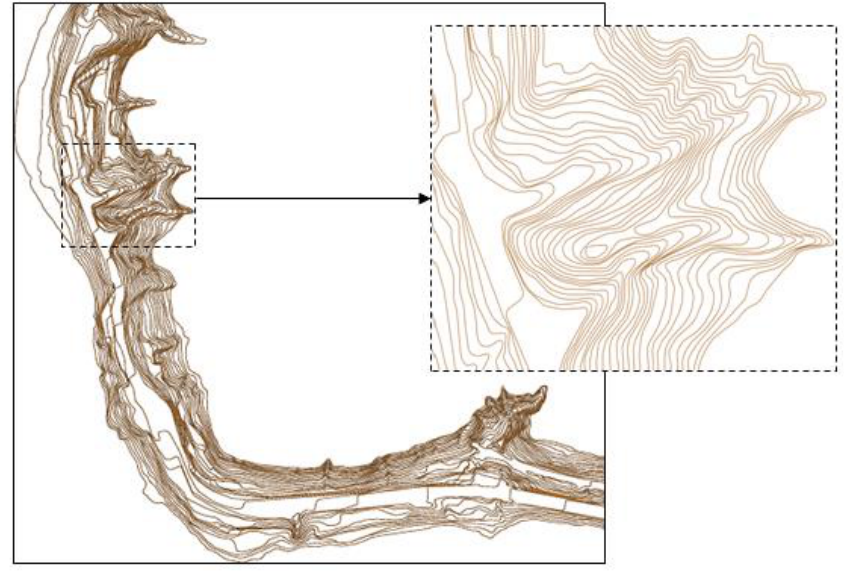
Figure 18. Simplified result with ODC method and DP-algorithm (parameter D ≥ 40.0, composed of 17,591 shape points).